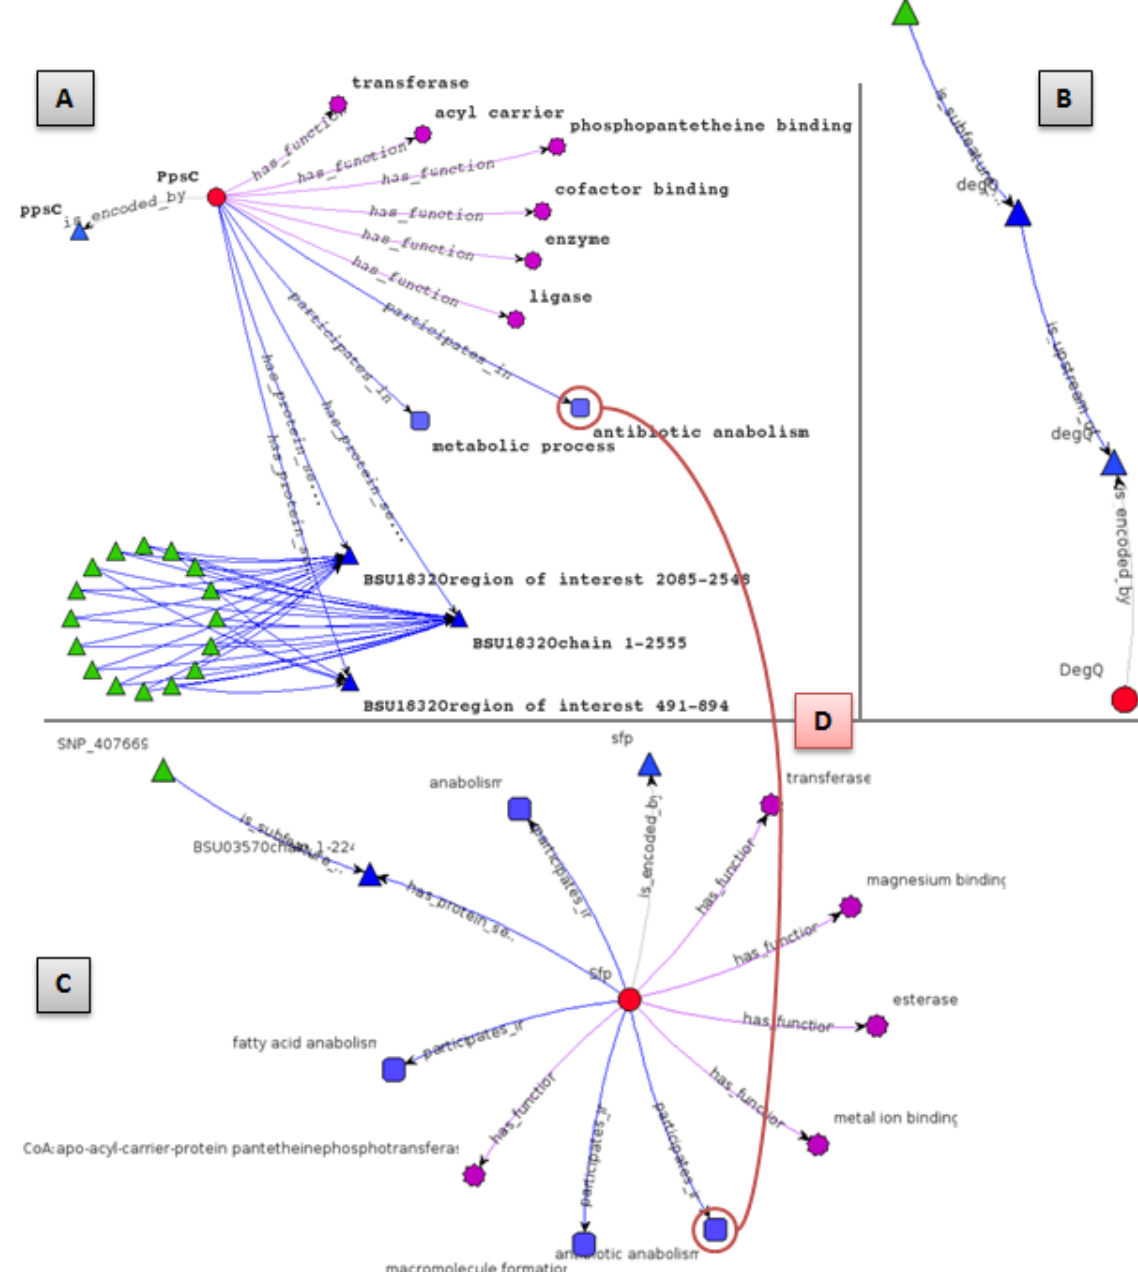
Figure 4. SNPs can be linked to phenotype at several levels of complexity. A: 16 SNPs (1sSNP & 15 nsSNPs- of which 9 are INDELs) associated with the protein chain of the plipistatin synthase subunit C, PpsC. 6 SNPs are found within the adenylation 1 region of the protein chain with 9 found within the epimerization region (please note that for the purpose of this graph the SNP_Labels as well as SNP_relation labels (is_subfeature_of) have been hidden).B: An eSNP within the promoter region of the pleiotropic regulator, DegQ. C: Visualisation of the insertion within the protein chain of the Surfactin synthetase-activating enzyme, SfP. D: It is clear that both SfP and PpsC are involved in the formation of